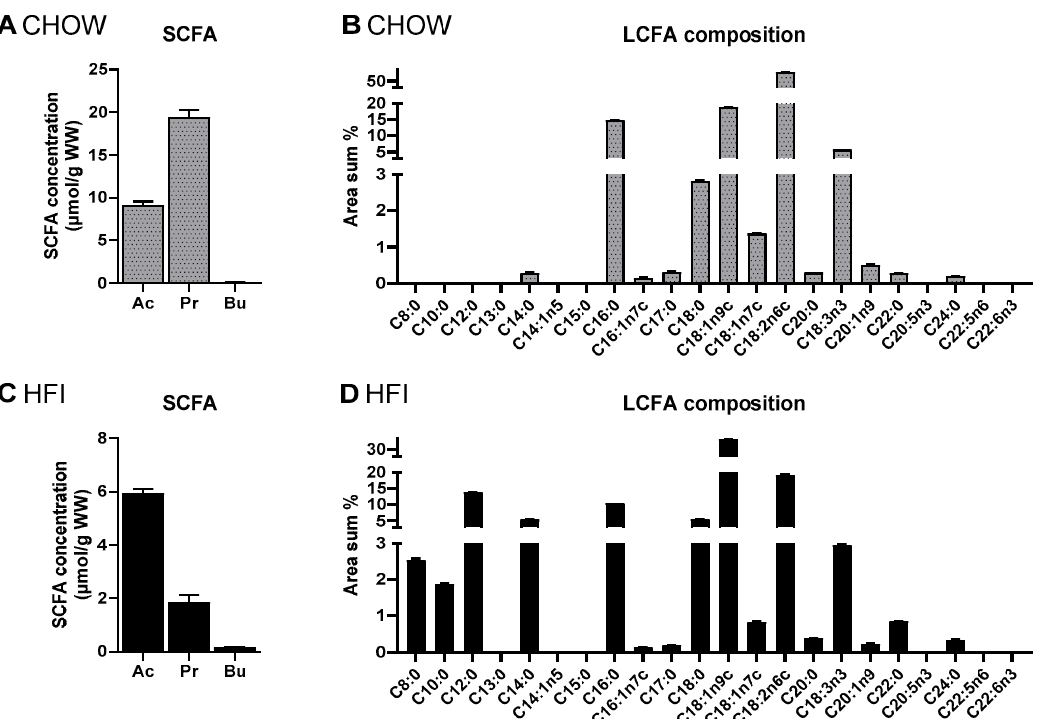
Figure 5. Fatty acid composition of diets used in these studies, measured by gas chromatography. Short-chain fatty acid (SCFA) concentration in ( A ) CHOW (Altromin fortified 1314) or ( C ) high-fat inulin diet (HFI, high-fat + 7% inulin). Long-chain fatty acid (LCFA) composition of the phospholipid fraction in the ( B ) CHOW or ( D ) HFI diet. Results are expressed as area percentage of individual fatty acids to total area of detected fatty acids. Data are mean + SEM ( n = 3). Statistics were not assessed due to small sample size.